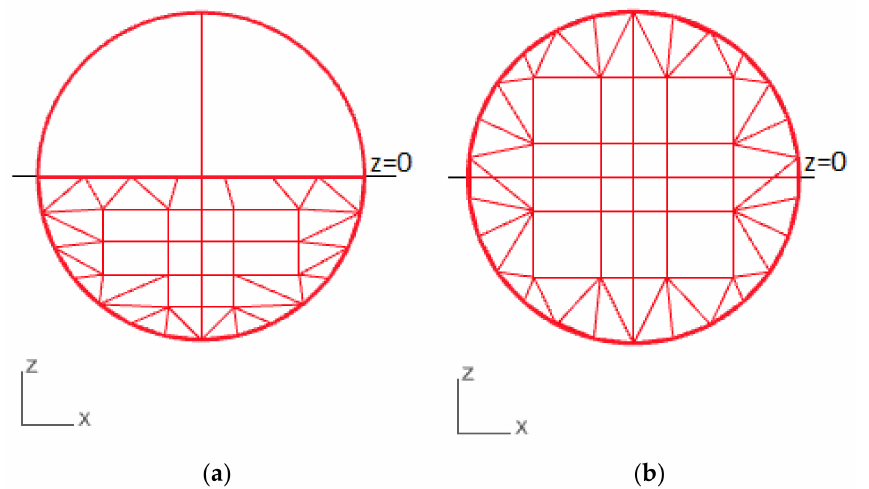
Figure 2. Nonlinear Froude-Krylov and Hydrostatic force meshing dependency. ( a ) Linear cal- culations with constant coefficients, ( b ) Weakly nonlinear calculations with instantaneous surface elevation dependent